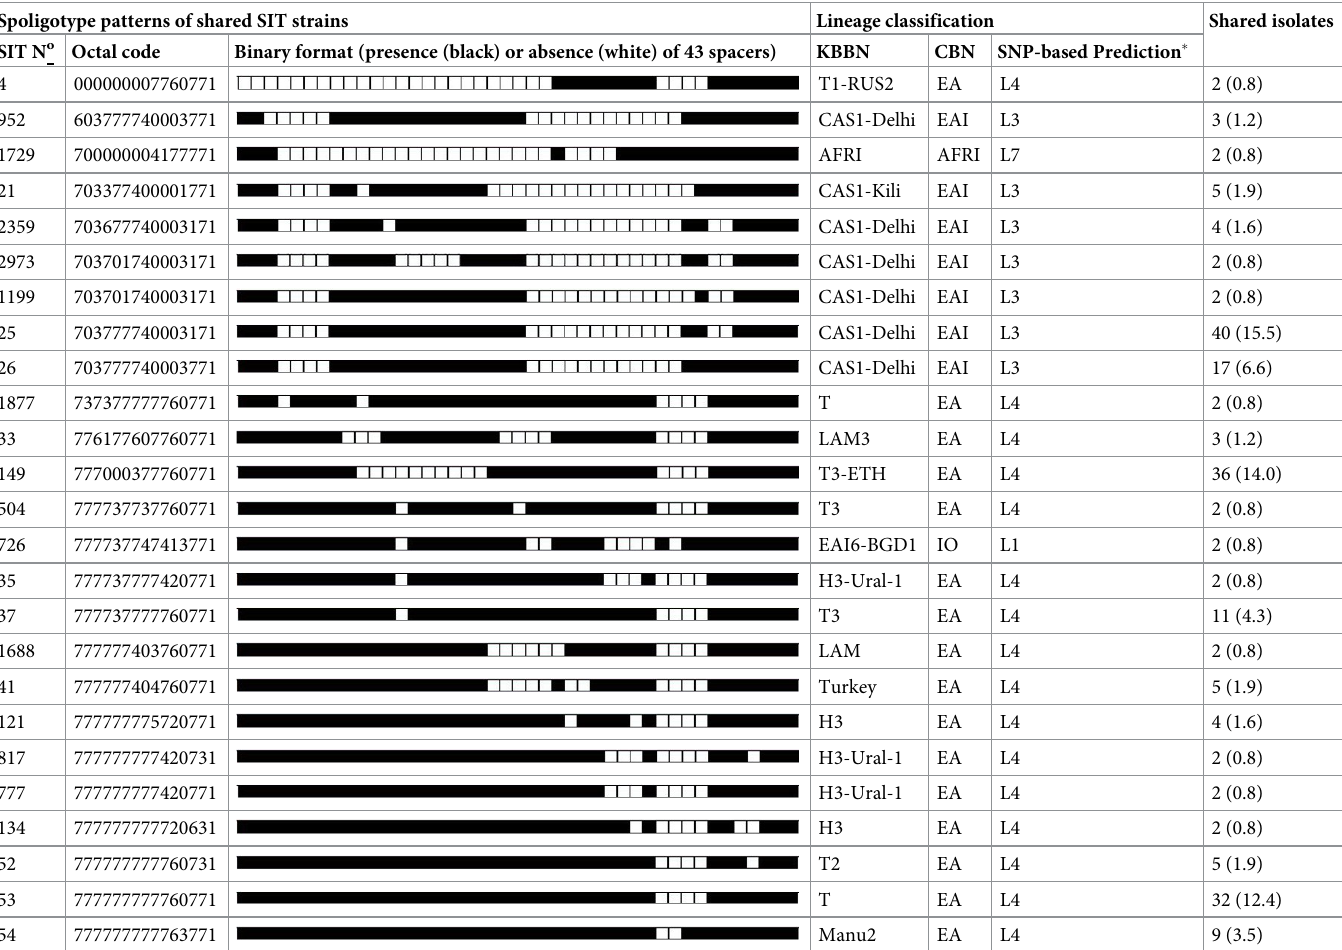
Table 3. Spoligotype descriptions of all registered SIT patterns with two or more isolates identified from 198 clinical samples collected from pulmonary TB and cer- vical TB lymphadenitis patients recruited at selected health facilities in Ethiopia in the years of 2016/17. Spoligotype patterns of shared SIT